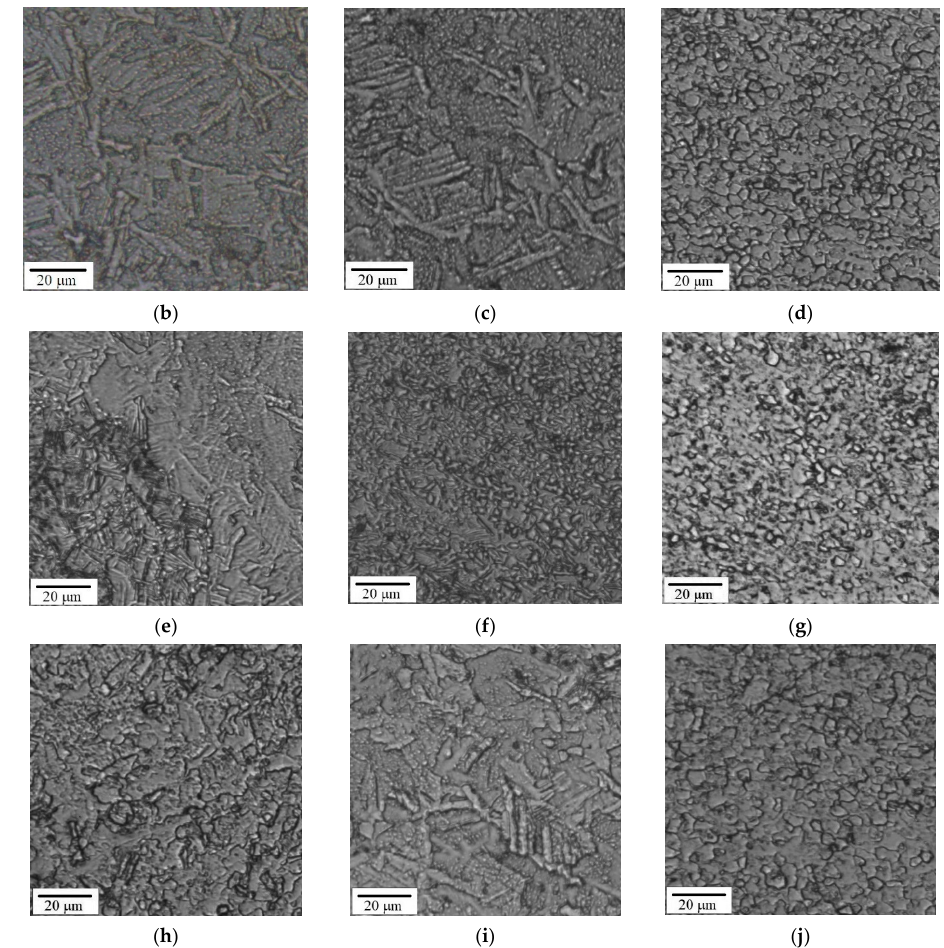
Figure 4. Optical micrographs of the weld: ( a ) cross-section showing the points from which micro- graphs ( b – j ) were taken; ( b ) optical micrograph taken at point 1; ( c ) optical micrograph taken at point 2; ( d ) optical micrograph taken at point 3; ( e ) optical micrograph taken at point 4; ( f ) optical micrograph taken at point 5; ( g ) optical micrograph taken at point 6; ( h ) optical micrograph taken at point 7; ( i ) optical micrograph taken at point 8; ( j ) optical micrograph taken at point 9. Figure 4b,c show that the microstructure of the upper part of the SZ (points 1 and 2)—namely, at depths of 0.6 mm and 1.6 mm—contained twins, whereas point 3 (Figure Table 2. Microstructure